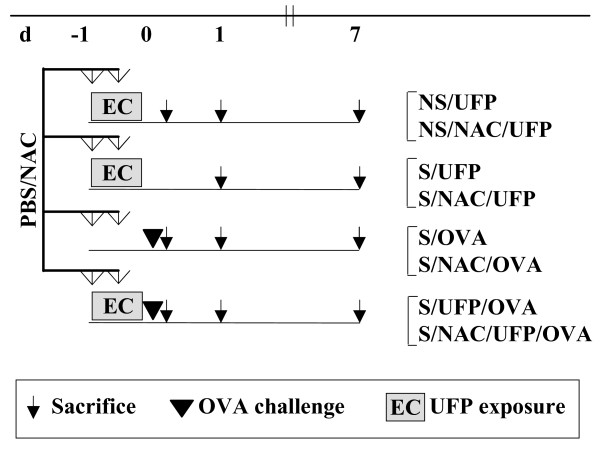
Experimental groups (left) and designation (right). EC, 24 h exposure to elemental carbon UFP (507 μg/m3); open arrows, 2× intraperitoneal injection with N-acetylcysteine; black triangle, OVA aerosol challenge; ↓, sacrifice, BAL, histology and electron microscopy. S, sensitized; NS, non sensitized; OVA, challenged with aerosolized OVA; UFP, exposed to EC-UFP.